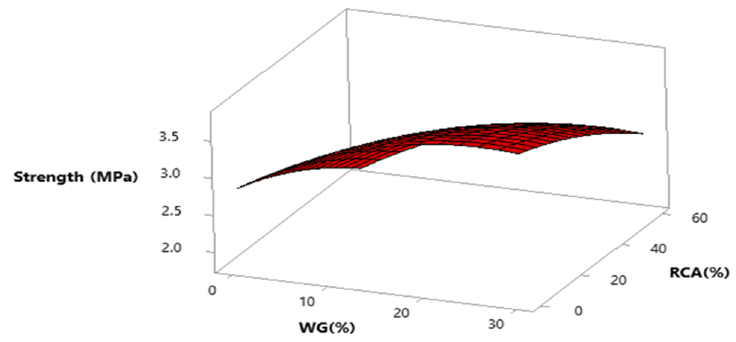
Figure 11. Three-dimensional response surface of split tensile strength.